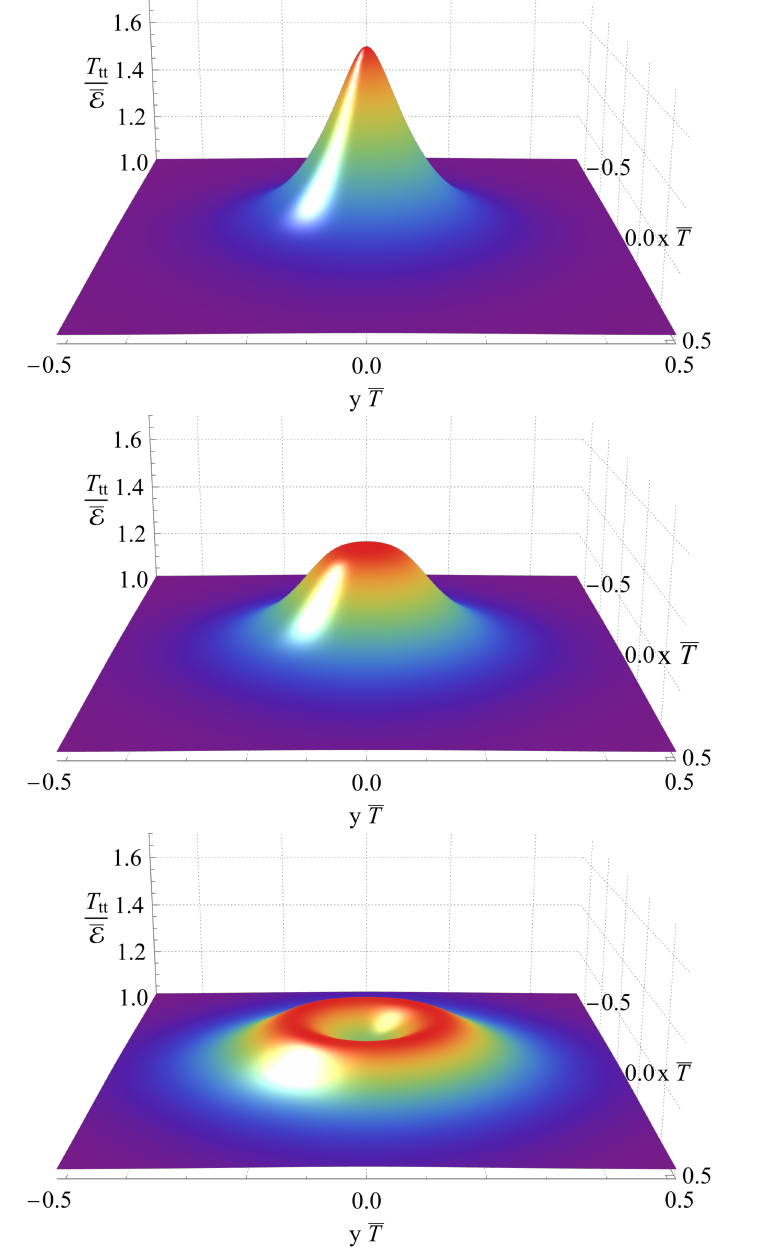
Figure 1 . Snapshots of the energy density in the lab frame, T tt , of the holographic solution at times tT = 0 , 0 . 08 , 0 . 16 , from top to